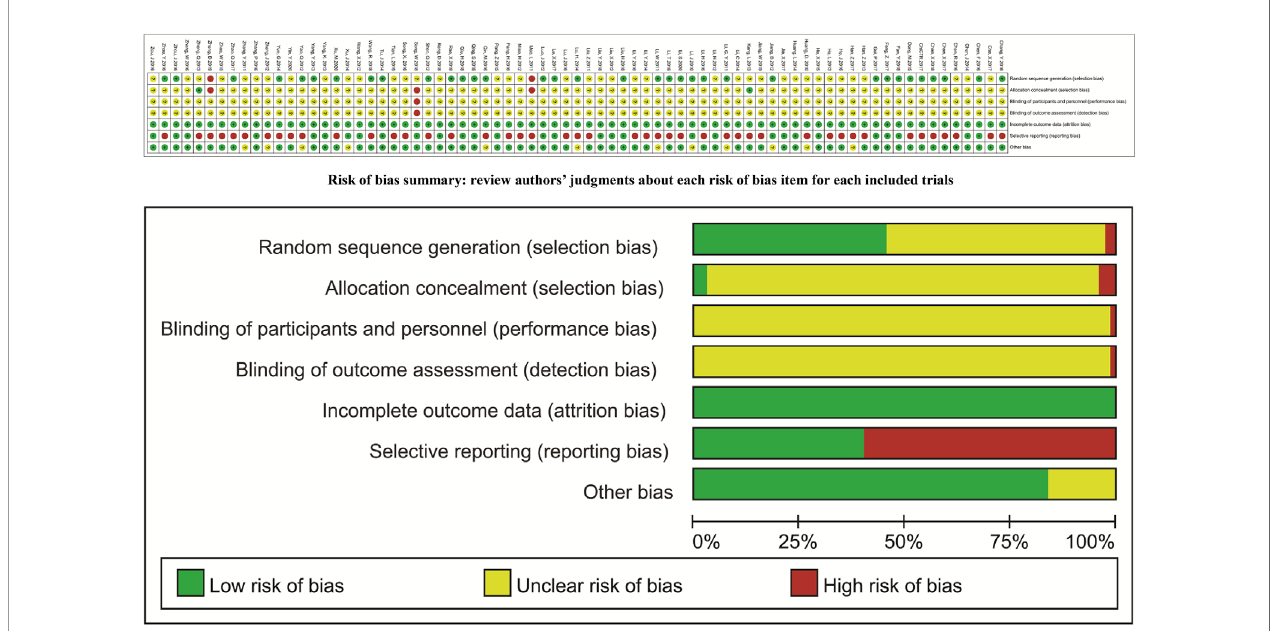
FIGURE 2 | Risk of methodological